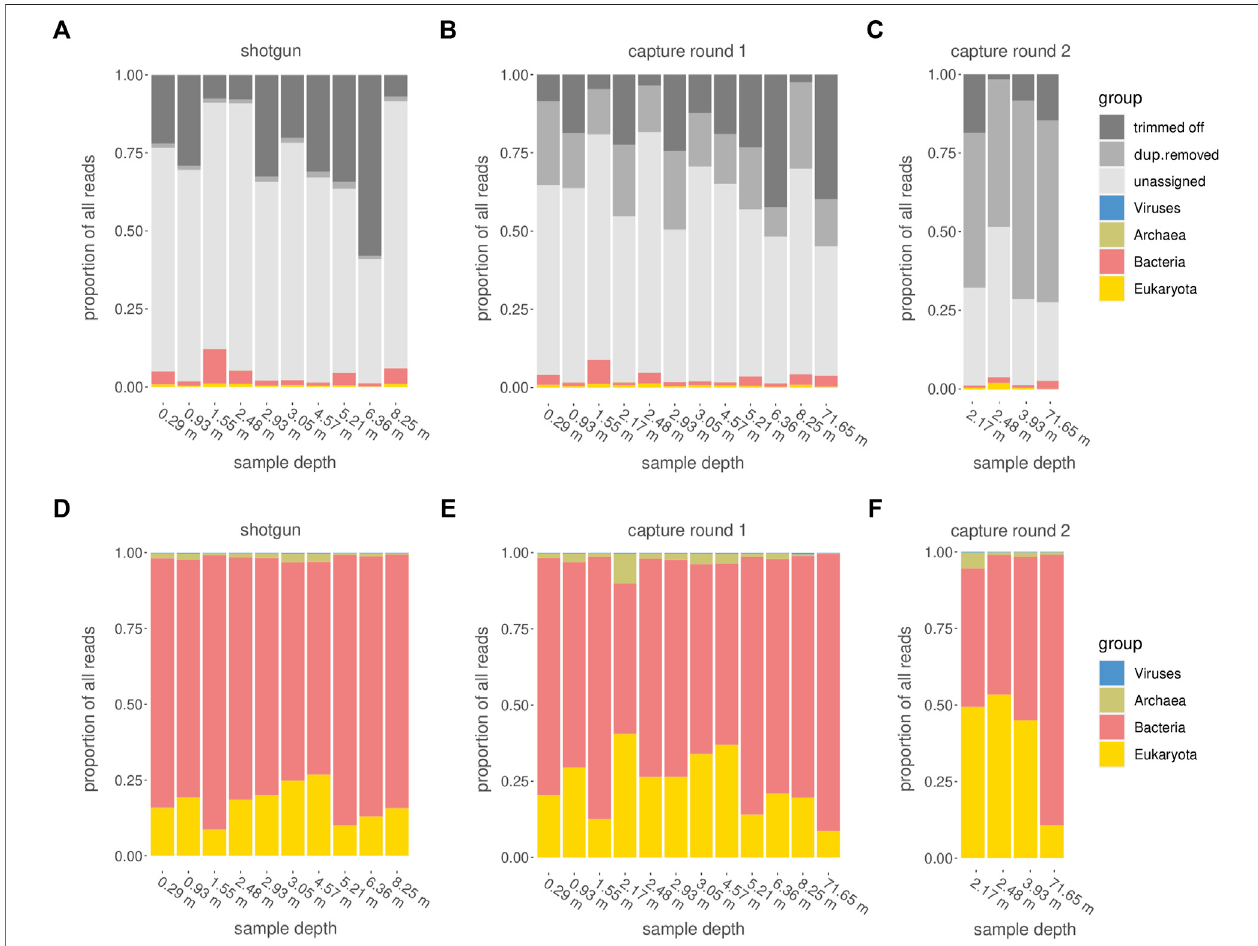
FIGURE 7 | Categorization of reads. (A – C) Assignment of raw reads, including the fractions of reads that did not pass quality or size fi ltering ( “ trimmed off ” ), PCR duplicates ( “ dup.removed ” ), and failed taxonomic assignment ( “ unassigned ” ). (D – F) Taxonomic assignment of reads which passed the quality control steps and were retained for further analysis. (A,D) : shotgun data, (B,E) fi rst round capture data, (C,F) second round capture data (only applied to a subset of samples).